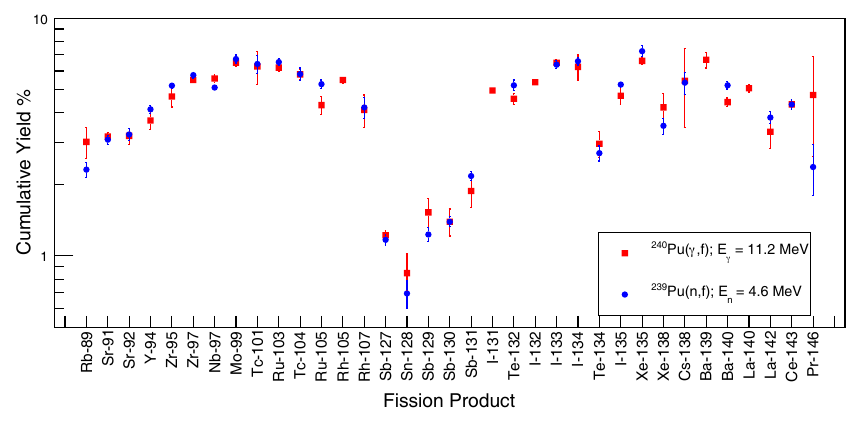
Figure 2. Preliminary FPYs from 240 Pu( γ ,f) at E γ = 11 . 2 MeV and 239 Pu(n,f) at E n = 4 . 6 MeV. The 239 Pu(n,f) FPYs include new measurements of short-lived FPYs in combination with 13 long-lived FPYs from Gooden et al.